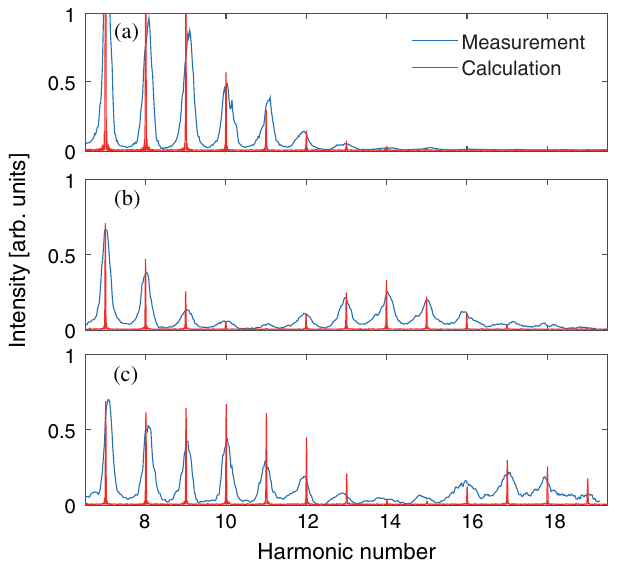
FIG. 2. Comparison of coherent radiation intensities at various harmonic numbers for single-stage HGHG and